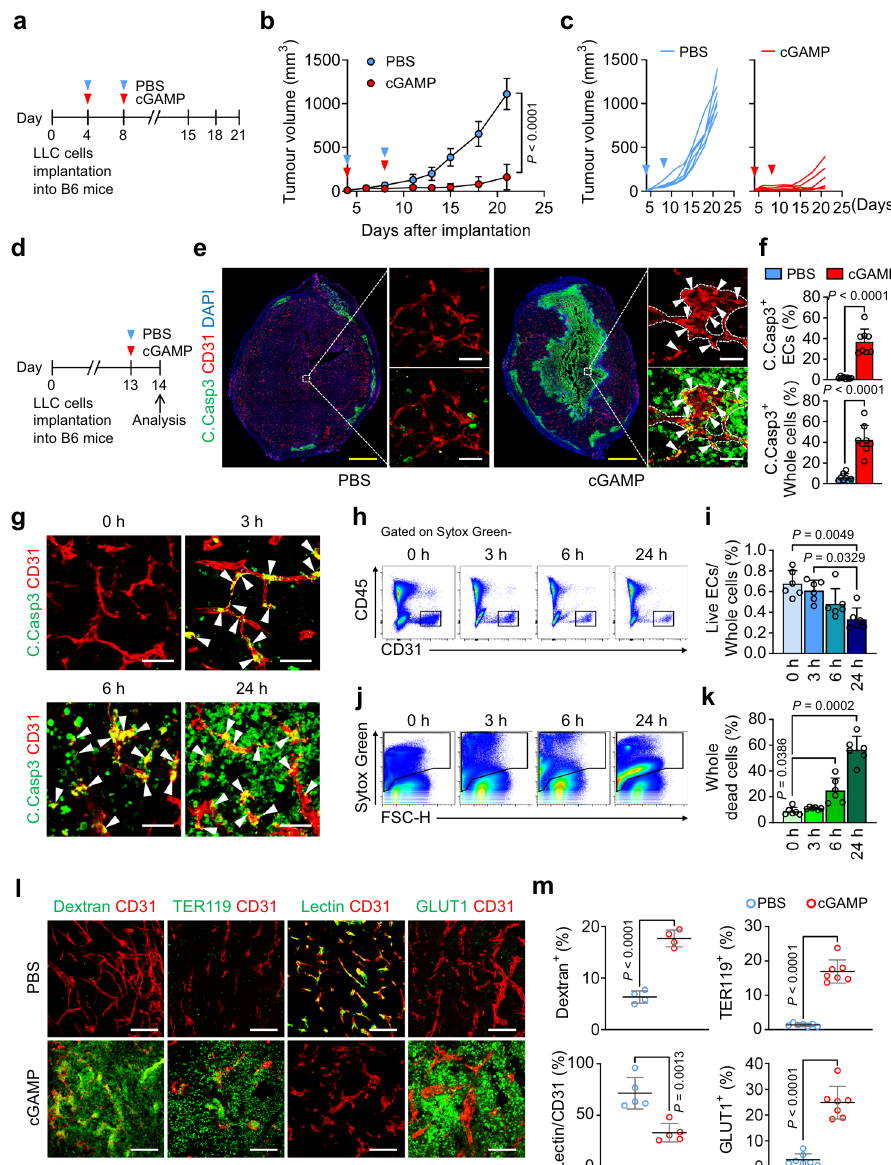
Fig. 1 Intratumoural injection of cGAMP strongly induces tumour vascular disruption in implanted LLC tumour. a - c Diagram depicting generation of implanted LLC tumour in B6 mice and treatment schedule of intratumoural (i.t.) PBS or cGAMP. Comparison of LLC tumour growths. n = 6 mice/group from two independent experiments. Dots and bars indicate mean ± SD. Plot indicates each individual tumour growth. d – f Diagram depicting generation of LLC tumour, i.t. PBS or cGAMP treatment, and tumour sampling at 24 h later. Representative images and comparisons of apoptosis in tumour ECs and whole tumour cells (whole cells). Dashed lines demarcate tumour vascular lining, while white arrowheads indicate apoptotic ECs. Scale bars, 1.0 mm (yellow bars) and 50 μ m (white bars). Each dot indicates a value from one mouse and n = 8 mice/group from two independent experiments. Vertical bars indicate mean ± SD. g – k Representative images showing temporal responses of tumour ECs and whole tumour cells following i.t. cGAMP treatment in implanted LLC tumour. n = 6 mice/group. Note that progressive tumour EC apoptosis followed by extensive tumour cell apoptosis. Scale bars, 50 μ m ( g ). Representative fl ow cytometry plots and comparisons showing gradual changes of live EC and dead cell populations. Each dot indicates a value from one mouse and n = 6 mice/group from three independent experiments. Vertical bars indicate mean ± SD. l , m Impaired vascular function 24 h after i.t. cGAMP treatment. Representative Images and comparisons of dextran leakage ( n = 4 images/4 mice), TER119 + RBC leakage ( n = 7 images/7 mice), lectin + vascular perfusion ( n = 5 images/5 mice) and GLUT1 + hypoxic area ( n = 7 images/7 mice). Scale bars, 100 μ m. Each dot indicates a value from one mouse from four independent experiments. Horizontal bars indicate mean ± SD. P values by two-tailed t-test ( b , f , m ), Kruskal – Wallis test followed by Dunn ’ s test ( i ) or Welch ’ s one-way ANOVA test followed by Dunnett ’ s T3 test ( k ). Source data are provided as a Source Data File. direct STING activation of tumour ECs. Together, the cGAMP- times with 2-day interval (Supplementary Fig 2b). Of note, there induced tumour vascular destruction and anti-tumour growth were no signi fi cant differences in tumour growth, tumour EC could be derived from STING activation of bystander cells in the apoptosis and whole tumour cell apoptosis between WT and tumour microenvironment, rather than from intrinsic STING STING i Δ EC mice (Supplementary Fig. 2c – g), implying that the cGAMP-induced tumour EC apoptosis was not mediated through activation of tumour cells or tumour ECs. NATURE COMMUNICATIONS| (2021) 12:4405